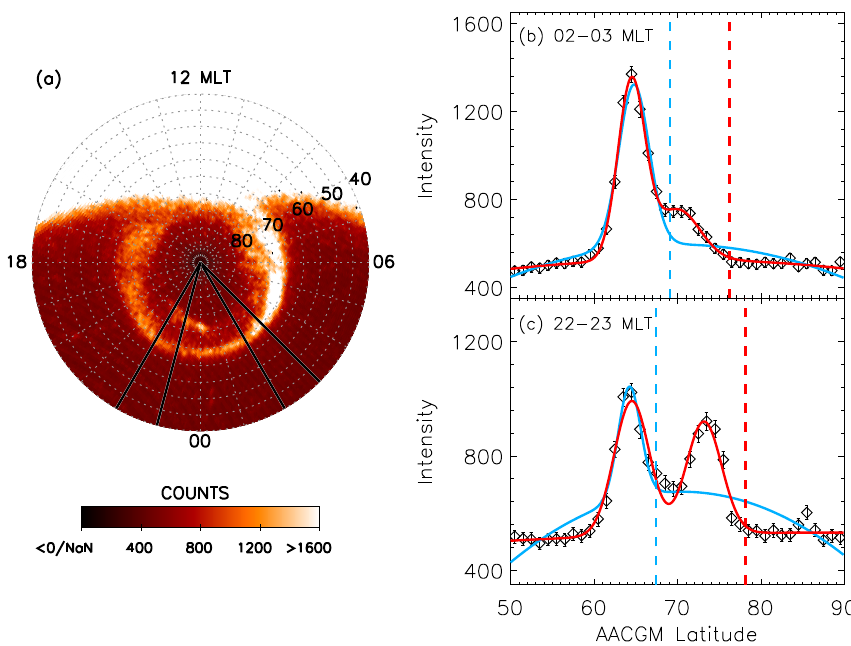
Fig. 1. FUV intensity observed by the IMAGE FUV WIC instrument at 00:10UT 1 February 2001 in AACGM coordinates (panel a ). The solid black lines mark the 02:00–03:00 and 22:00–23:00MLT sectors. All count values above 1600 have been saturated. The latitudinal luminosity intensity profiles corresponding to these MLT sectors are shown in panels (b) and (c) , respectively. The black diamonds show the mean count values of the intensity profiles. The standard error on these intensity count values are shown. The blue curves show the result of fitting the function F s (λ) to these intensity profiles with the vertical blue dashed lines indicating the PALBs derived from these fits for each profile. The red curves show the result of fitting the function F d (λ) to these intensity profiles with the vertical red dashed lines indicating the PALBs derived from these